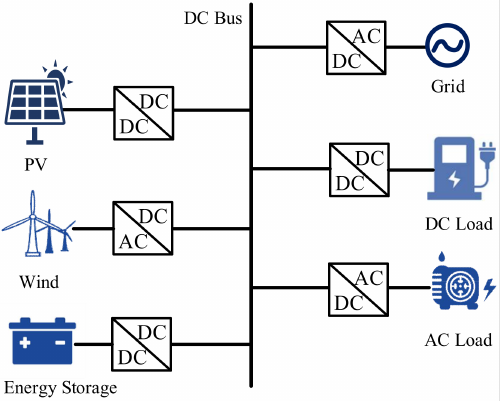
Figure 3. The typical topology of a dc microgrid.